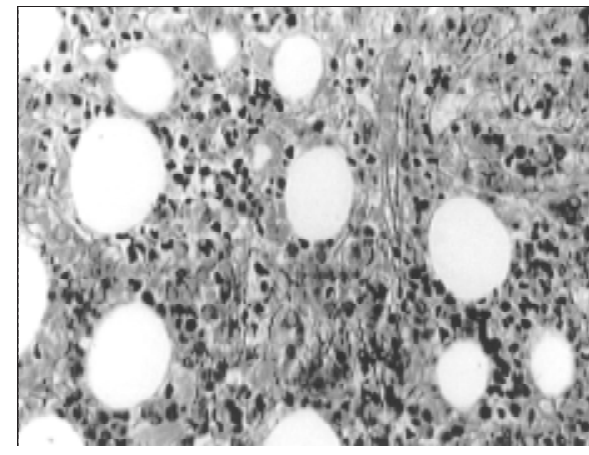
Figure 2 – Bone marrow biopsy showing reduction of marrow fibrosis (from grade IV to